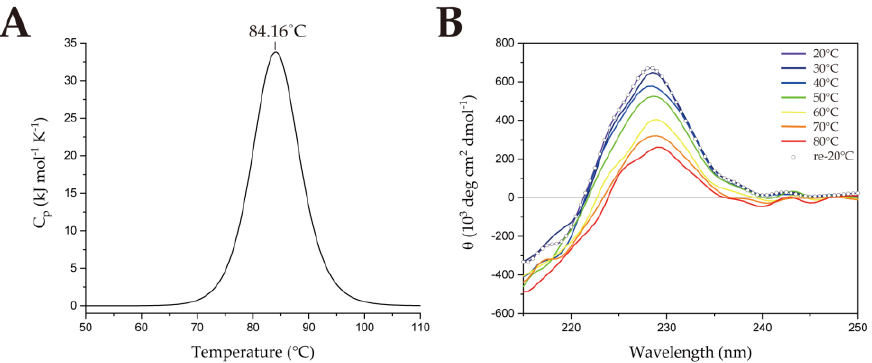
Figure 2. Thermostability of SsoSSB 1 – 114 . ( A ) Melting temperature (T m ) of SsoSSB 1 – 114 measured by differential scanning calorimetry. ( B ) Circular dichroism spectroscopy was used to investigate the effect of temperature on the secondary structure of SsoSSB 1 – 114 .